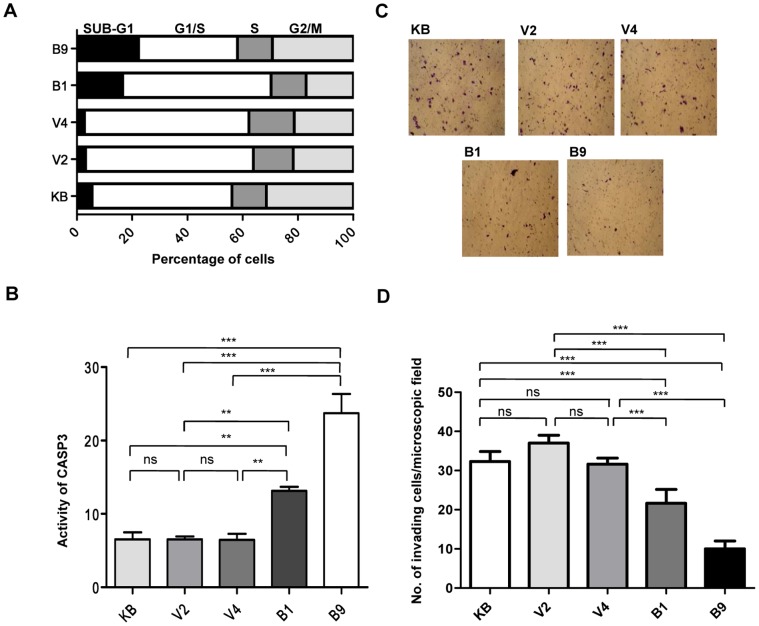
Increased apoptosis and decreased invasion in MCPH1 overexpressing cells.(A) The analysis of sub-G1 populations (a measure of cell death) in PI stained KB, V2, V4, B1 and B9 cells by flow cytometry. The graph represents one of the three separate experiments. Note higher sub-G1 populations in MCPH1 overexpressing B1 and B9 cells in comparison to KB, V2 and V4 cells. The mean values (%) ± SDs for sub-G1 populations in different cells are as follows: KB, 5.07±0.63; V2, 2.06±0.71; V4, 2.40±0.48; B1, 16.16±0.57; and B9, 22.64±0.45. (B) Analysis of apoptosis by in
vitro quantitation of CASP3 activity. Note significantly increased CASP3 activity in B1 and B9 cells in comparison to KB, V2 and V4 cells. The values shown are mean±SD of three separate experiments. (C) Analysis of cell invasion in KB cells, and V2, V4, B1 and B9 clones. Note MCPH1 overexpression reduced invasiveness in B1 and B9 cells as compared to KB, V2 and V4 cells. (D) The quantitative representation of the cell invasion assay data. The values are the mean±SD of the number of invaded cells counted in four random microscopic fields. Abbreviations: ns, statistically not significant; **p<0.005; and, ***p<0.001.